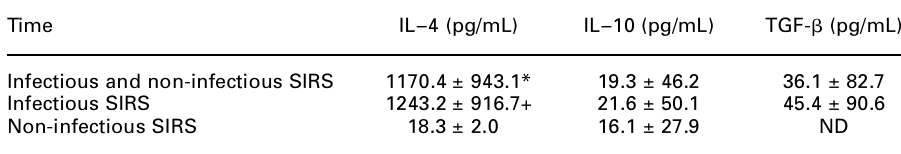
Table 1. Serum levels of IL–4, IL–10 and TGF- b in patients with SIRS at the time of diagnosis (set A), and five days later (set B) Set A Time